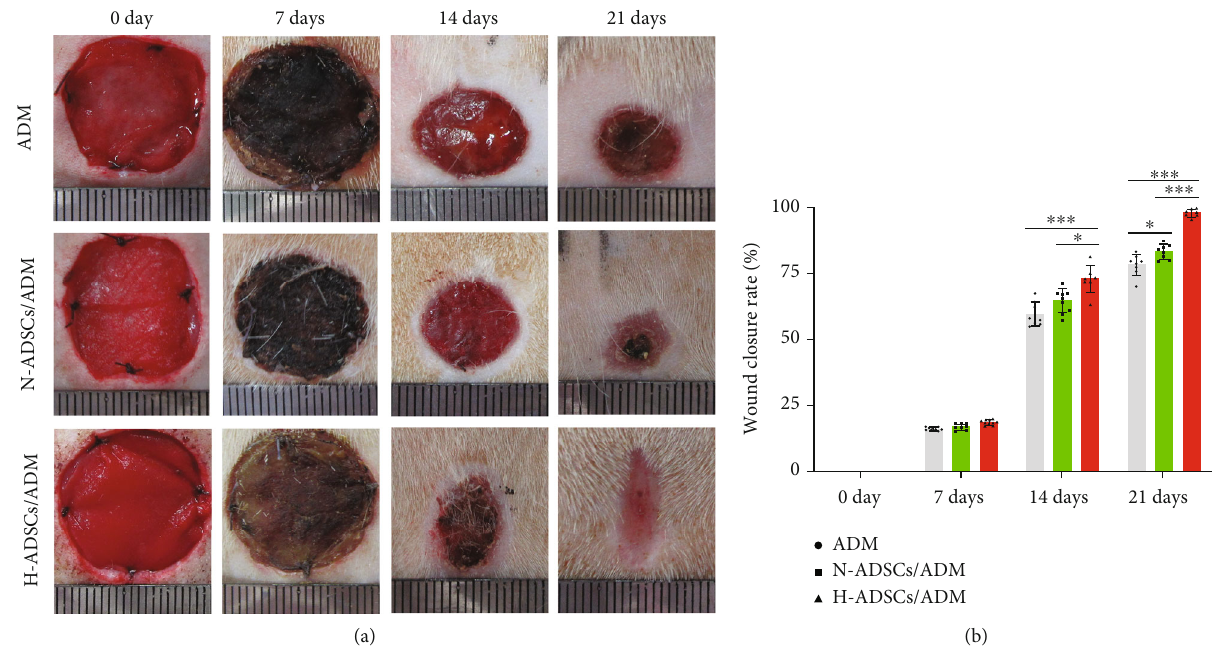
Figure 7: H-ADSCs/ADM facilitating diabetic wound healing. (a) Photos of the skin wound healing in diabetic rat among the ADM, N- ADSCs/ADM, and H-ADSCs/ADM groups at postoperative 0, 7, 14, and 21 days. (b) Statistical analysis of wound area among the three groups at postoperative 0, 7, 14, and 21 days, n = 8 per group. All data are shown as means ± standard deviation ( ∗ P < 0 : 05 , ∗∗ P < 0 : 01 , and ∗∗∗ P < 0 : 001